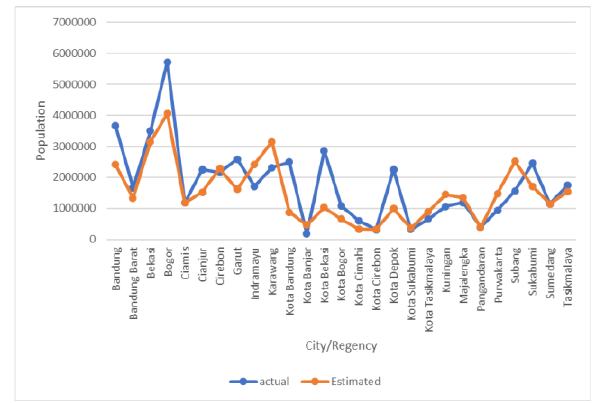
Figure 3. Comparison of estimated populations to actual populations in Jawa Barat Province in 2017 by city/regency.